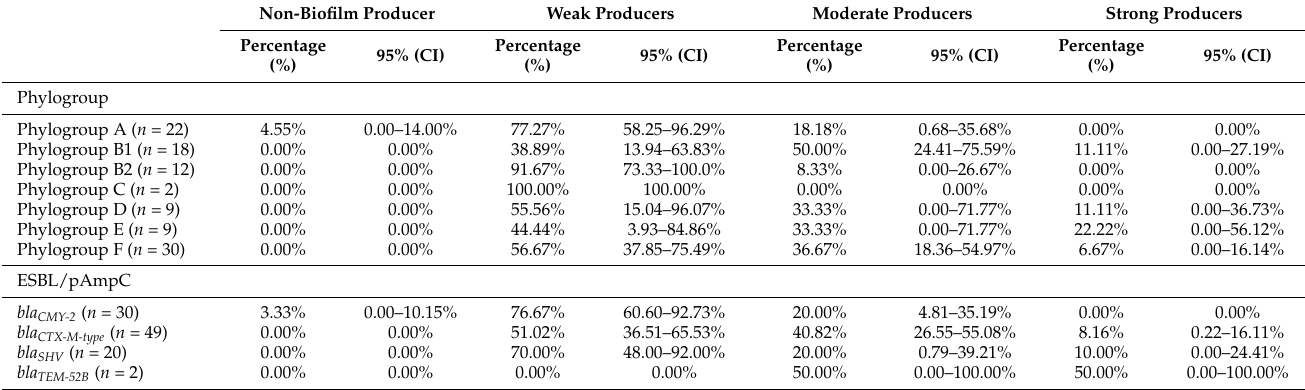
Table 2. Ability to form biofilms by ESBL/pAmpC-EC, according to phylogroup and ESBL/pAmpC gene.